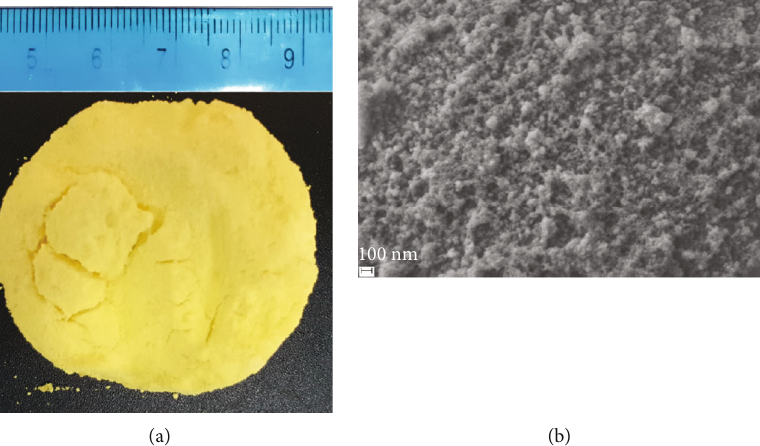
Figure 4: Photograph (a) and micrograph at × 30k magni fi cation (b) of the Schi ff base-modi fi ed aerogel. Table 1: Physical/structural properties of the functional aerogel-like monolith adsorbent. Bulk density (g cm − 3